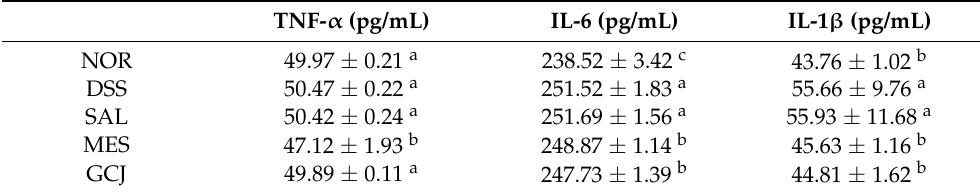
Table 2. Effects of Gochujang on serum levels of inflammatory cytokines in DSS-treated